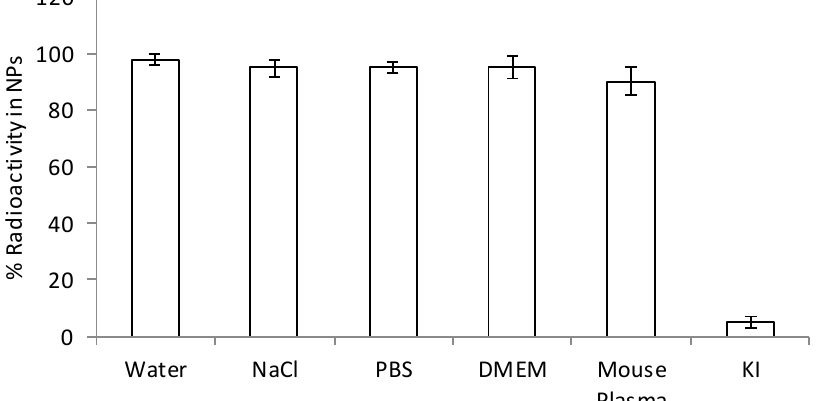
Figure 4. Radiochemical stability of core-labelled PEG-AuNPs@[ 4 ] − in different media; NaCl: physiologic saline solution (0.9%); PBS: 10 mM phosphate buffered solution; DMEM: Culture media, cocktail of 8 salts, 15 amino acids, 8 vitamins and glucose; KI: potassium iodide solution (10 µM).